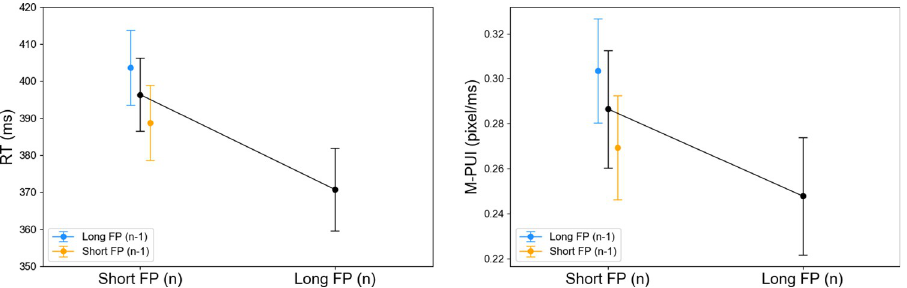
Fig 5. General FP/SE effects on RT and M-PUI. Error bars represent standard errors.